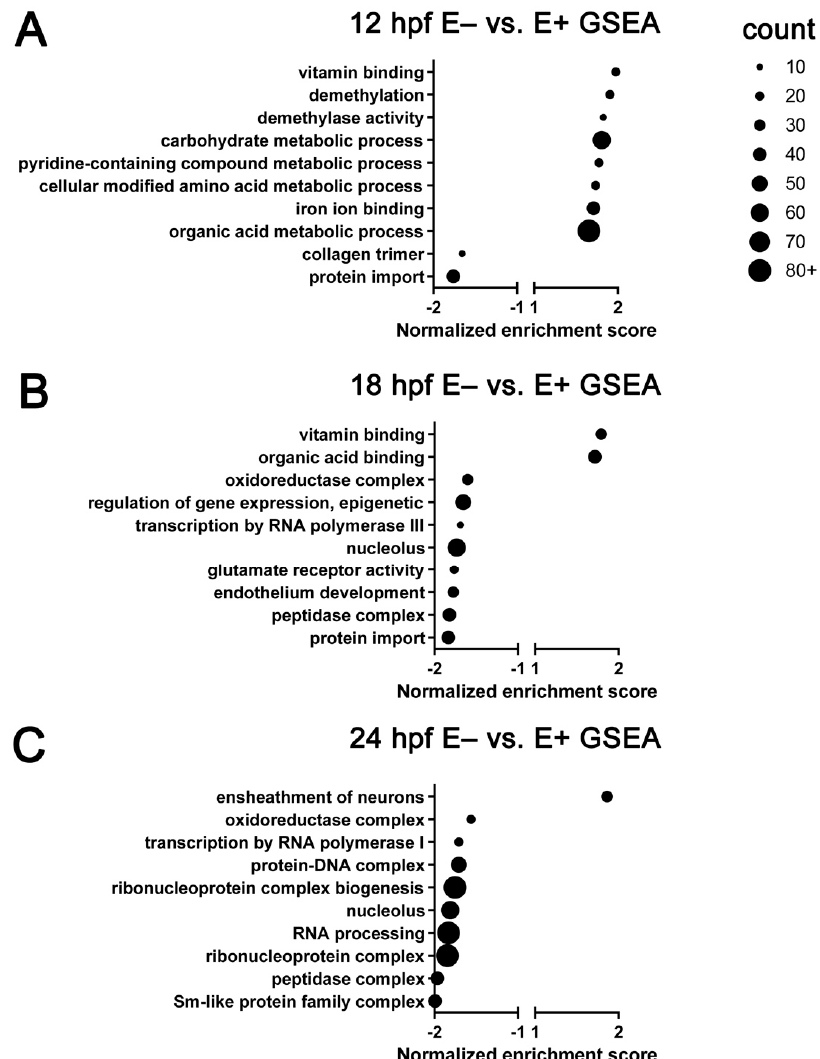
Figure 4. Gene ontology terms enriched by gene set enrichment analysis of all expressed genes. GO annotations associated with all genes ( n = 22,796) pre-ranked, analyzed by time (12, 18, 24 hpf) and organized by normalized enrichment score. Top 10 significant ( FDR < 0.25) GO terms are separated by expression at ( A ) 12 hpf, ( B ) 18 hpf and ( C ) 24 hpf. Approximate number of genes found enriched in each term indicated by dot size. Positive enrichment score indicates increased expression in E– relative to E+ embryos, negative enrichment score indicates decreased expression in E– relative to E+ embryos. Normalized enrichment score automatically computed with enrichment and adjusted p -value by WebGestalt.